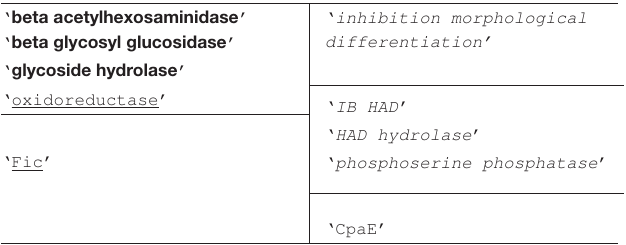
TABLE 3 | Synteny phrases for linguistic search after 2nd update using synteny annotations of Cellulomonas Ms1 RNA homologs ( Supplementary Figure 3 ).